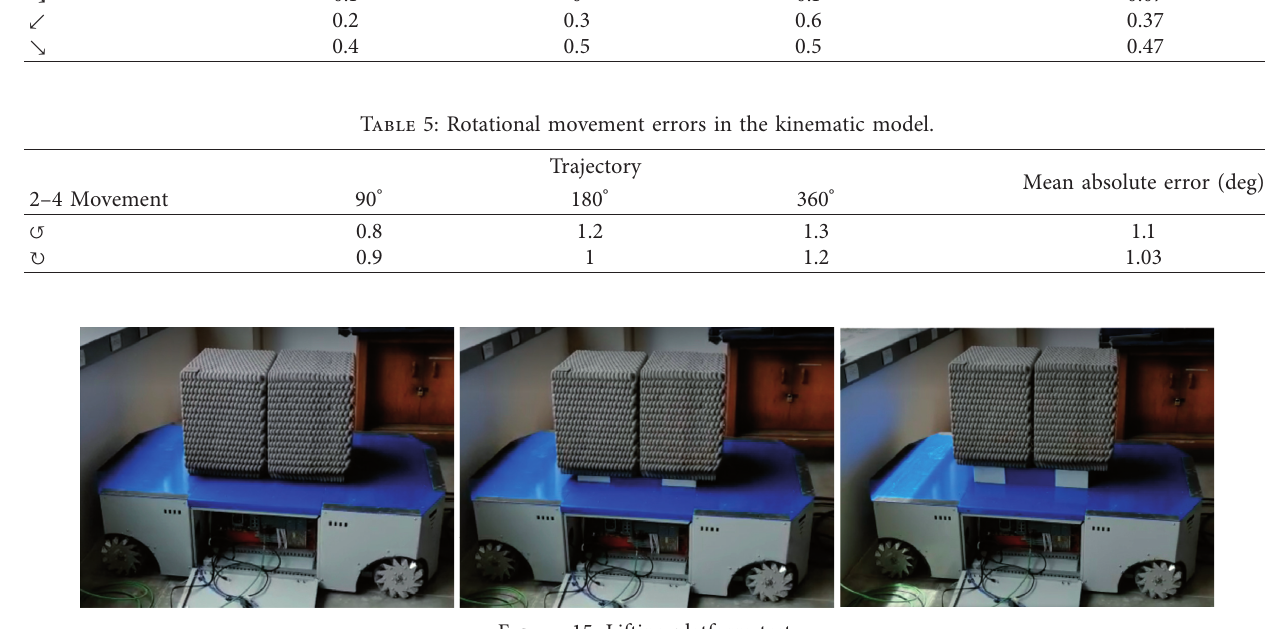
Figure 15: Lifting platform